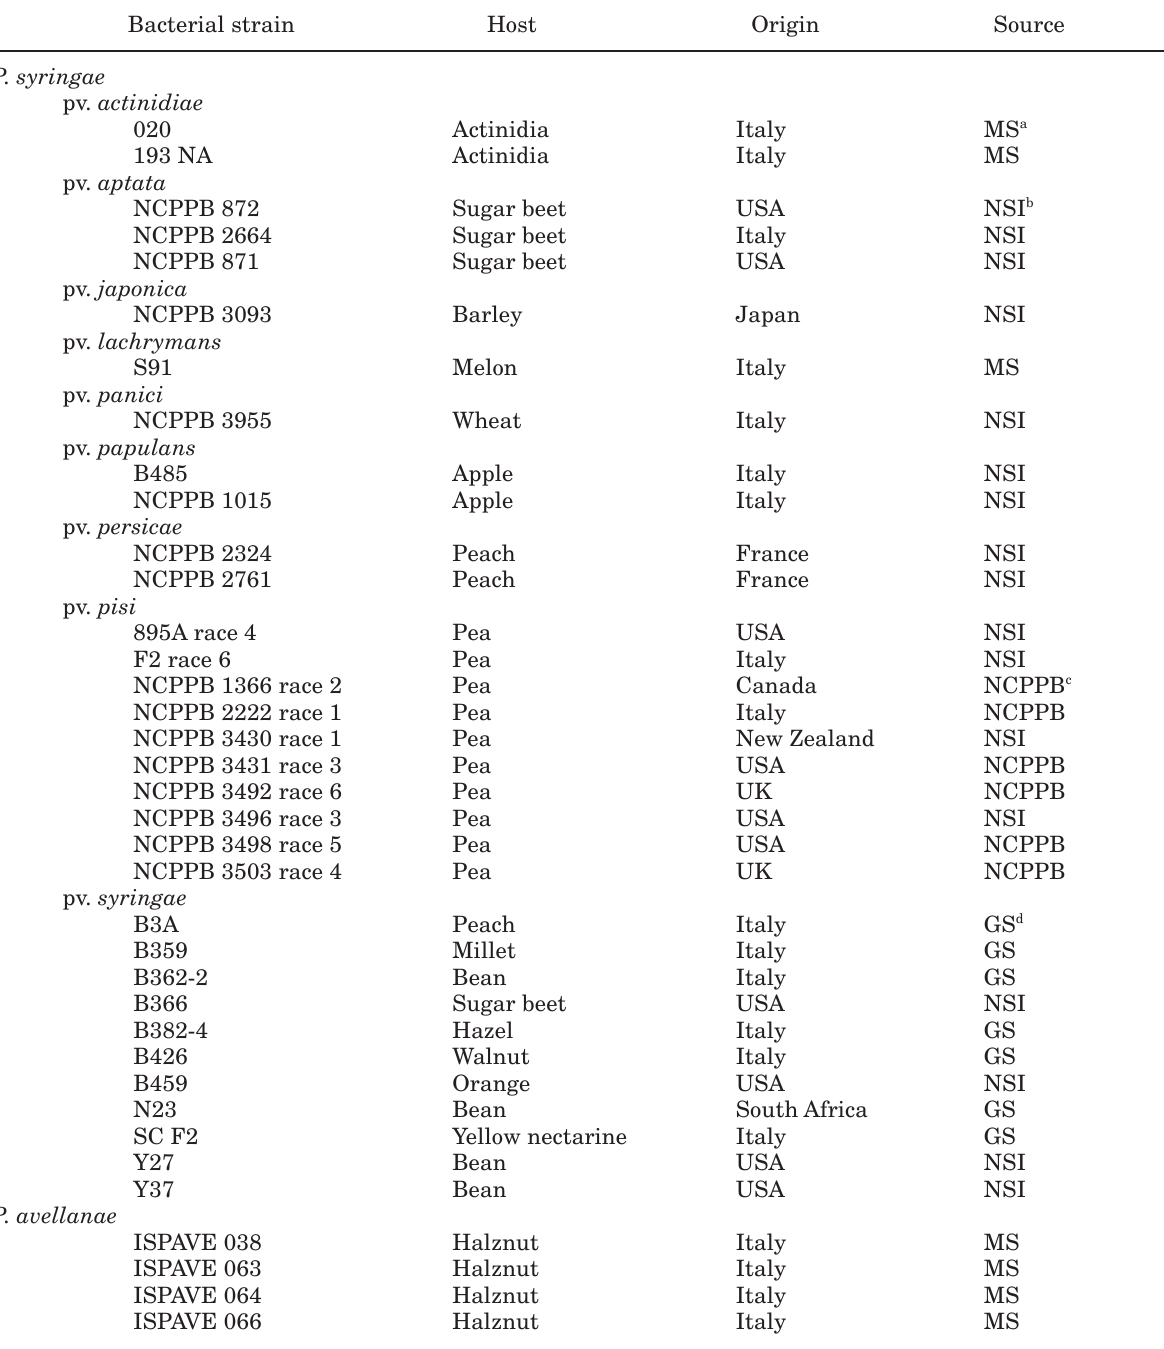
Table 1. Characteristics of Pseudomonas syringae pathovars and P. avellanae strains used in this study. Bacterial strain Host Origin